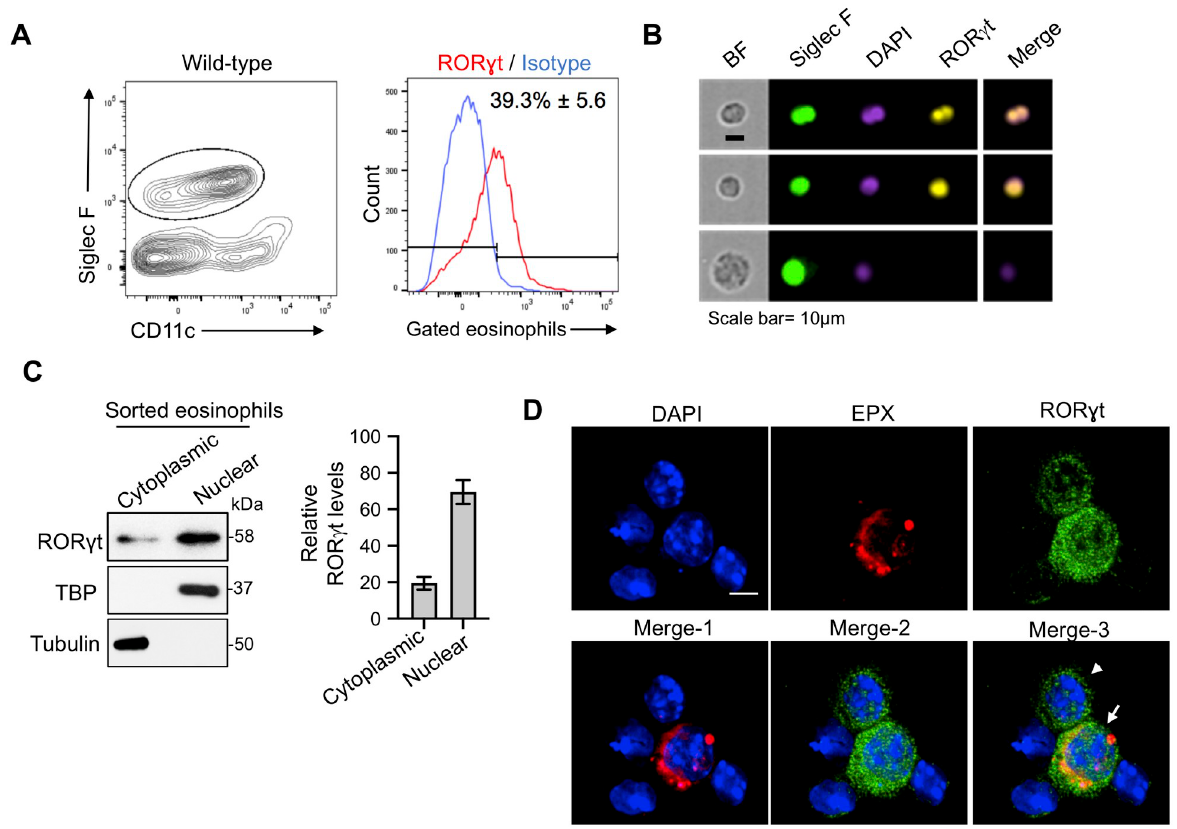
Fig 2. ROR γ t is expressed in lung eosinophils from mice with acute and allergic aspergillosis. (A) Flow cytometry (allergy model) . Allergic pulmonary aspergillosis was modeled as in Fig 1A. Lung cells were fixed, permeabilized and stained with anti-ROR γ t or isotype control. FACS plots are representative of 2 experiments, each with 4–5 mice per group. The means ± SE of ROR γ t-staining eosinophils combining each mouse experiment are shown next to the histogram. (B) Imaging flow cytometry (allergy model) . As is Fig 2A, except lung cells were analyzed by imaging flow cytometry after staining for Siglec F, DAPI (nuclear stain) and ROR γ t. Shown are representative output images from > 100 analyzed cells. BF; Bright field. Scale bar, 10 μ m. (C) Immunoblotting (allergy model) . As in Fig 2A except eosinophils were purified by flow-sorting. Cytoplasmic and nuclear extracts were prepared by cellular fractionation, resolved by SDS-PAGE and analyzed by immunoblotting with primary antibodies against ROR γ t, TATA-binding protein (TBP) and α -tubulin. TBP was used as nuclear and α -Tubulin as cytoplasmic controls, respectively. Left panel shows representative immunoblots. Right panel shows the means ± SD of the relative density from 2 immunoblots probed for ROR γ t. (D) Confocal microscopy (acute infection model) . C57BL/6 mice were infected with 5 x 10 7 A . fumigatus conidia. Two days post-infection, cells were harvested by BAL, permeabilized, and stained for the eosinophil marker, EPX (red), ROR γ t (green) and DAPI (blue). Merge-1: DAPI + EPX; Merge-2: DAPI + ROR γ t; Merge-3: DAPI + EPX + ROR γ t. Scale bar = 5 μ m. The arrow points to an eosinophil while the arrowhead points to a presumed neutrophil. Both cells exhibit ROR γ t